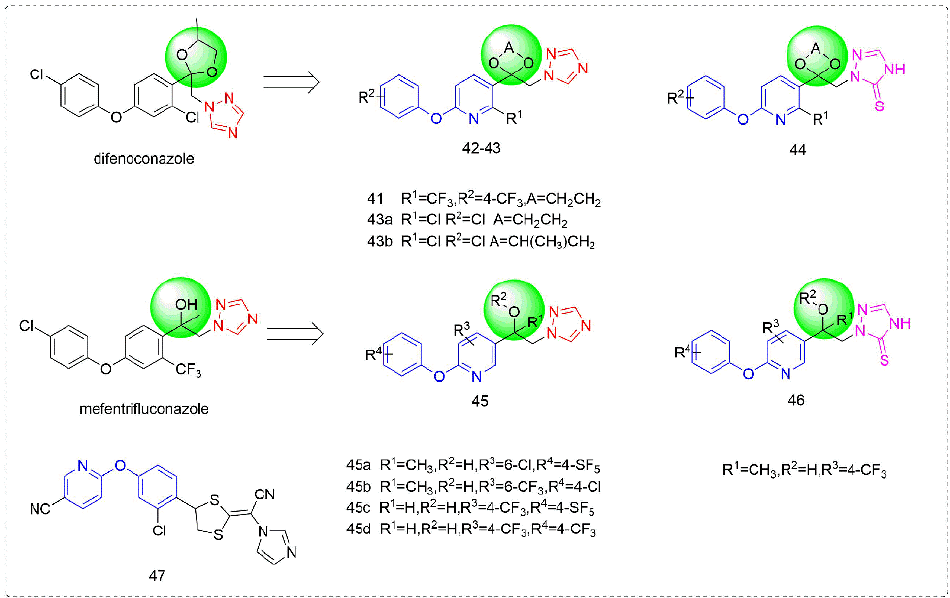
Figure 8. Sterol biosynthesis inhibitors containing phenoxypyridine.